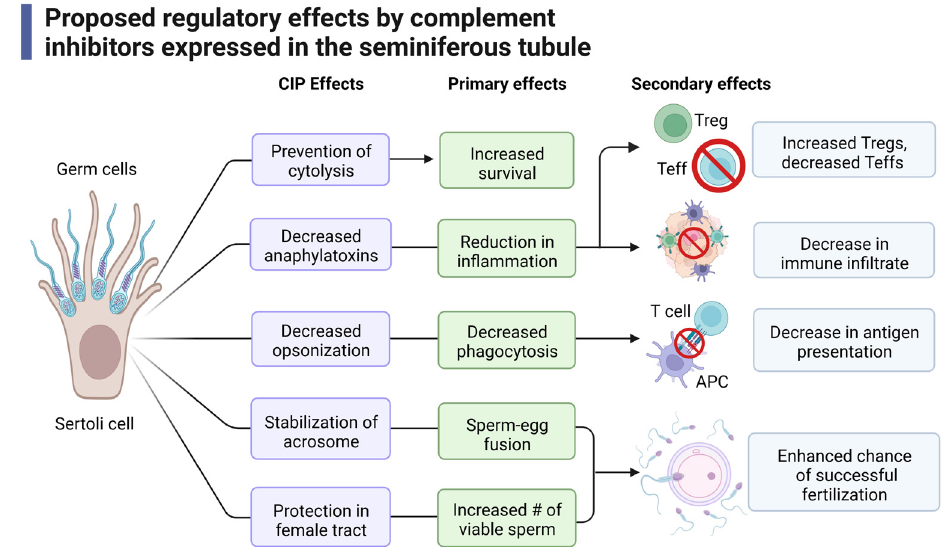
Figure 5. Proposed mechanisms of immune regulation by complement inhibitors expressed in the seminiferous tubule. Expression of complement inhibitors by Sertoli cells and germ cells play many different and distinct roles including direct inhibition of the complement system, modulation of immune cell activation, fertility, and fertilization. CIP: complement inhibitory proteins. This figure was made with BioRender, accessed on 1 December 2022.